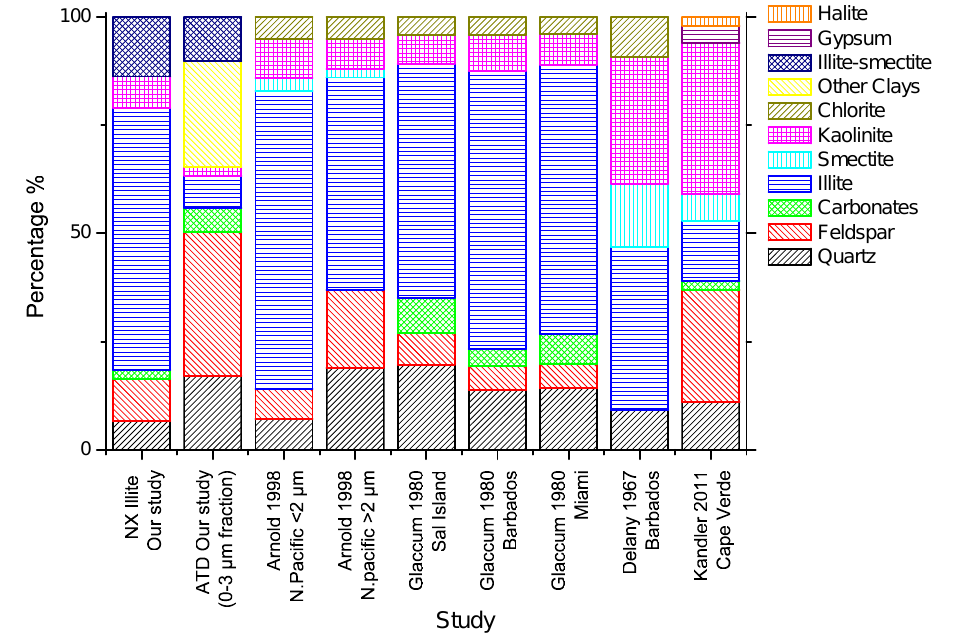
Fig. 1. Summary of mineralogical composition of NX illite, Arizona Test Dust and samples of airborne dust collected some distance from the source regions. See Table 1 for corresponding